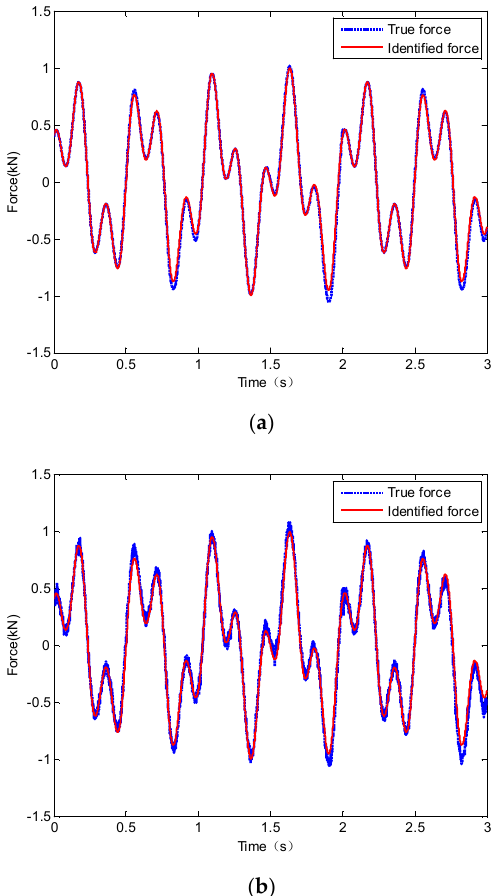
Figure 7. Identification of multi-frequency external force considering geometric nonlinearity. ( a ) Force identification result without measurement noise. ( b ) Force identification result with 5% measurement noise.